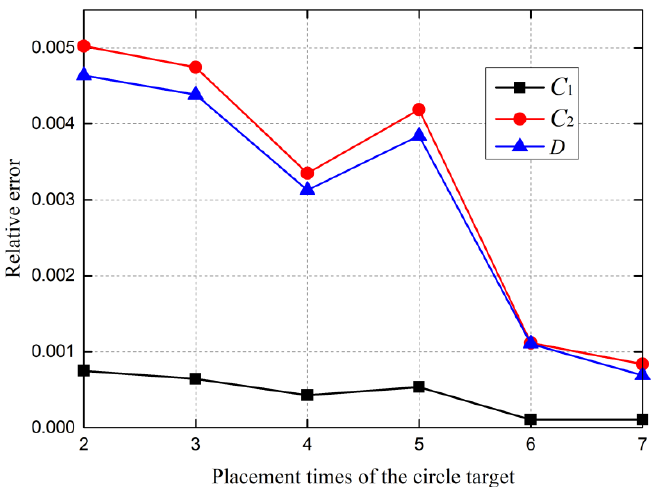
Figure 7. Influence of the number of circular target placements on the calibration accuracy.